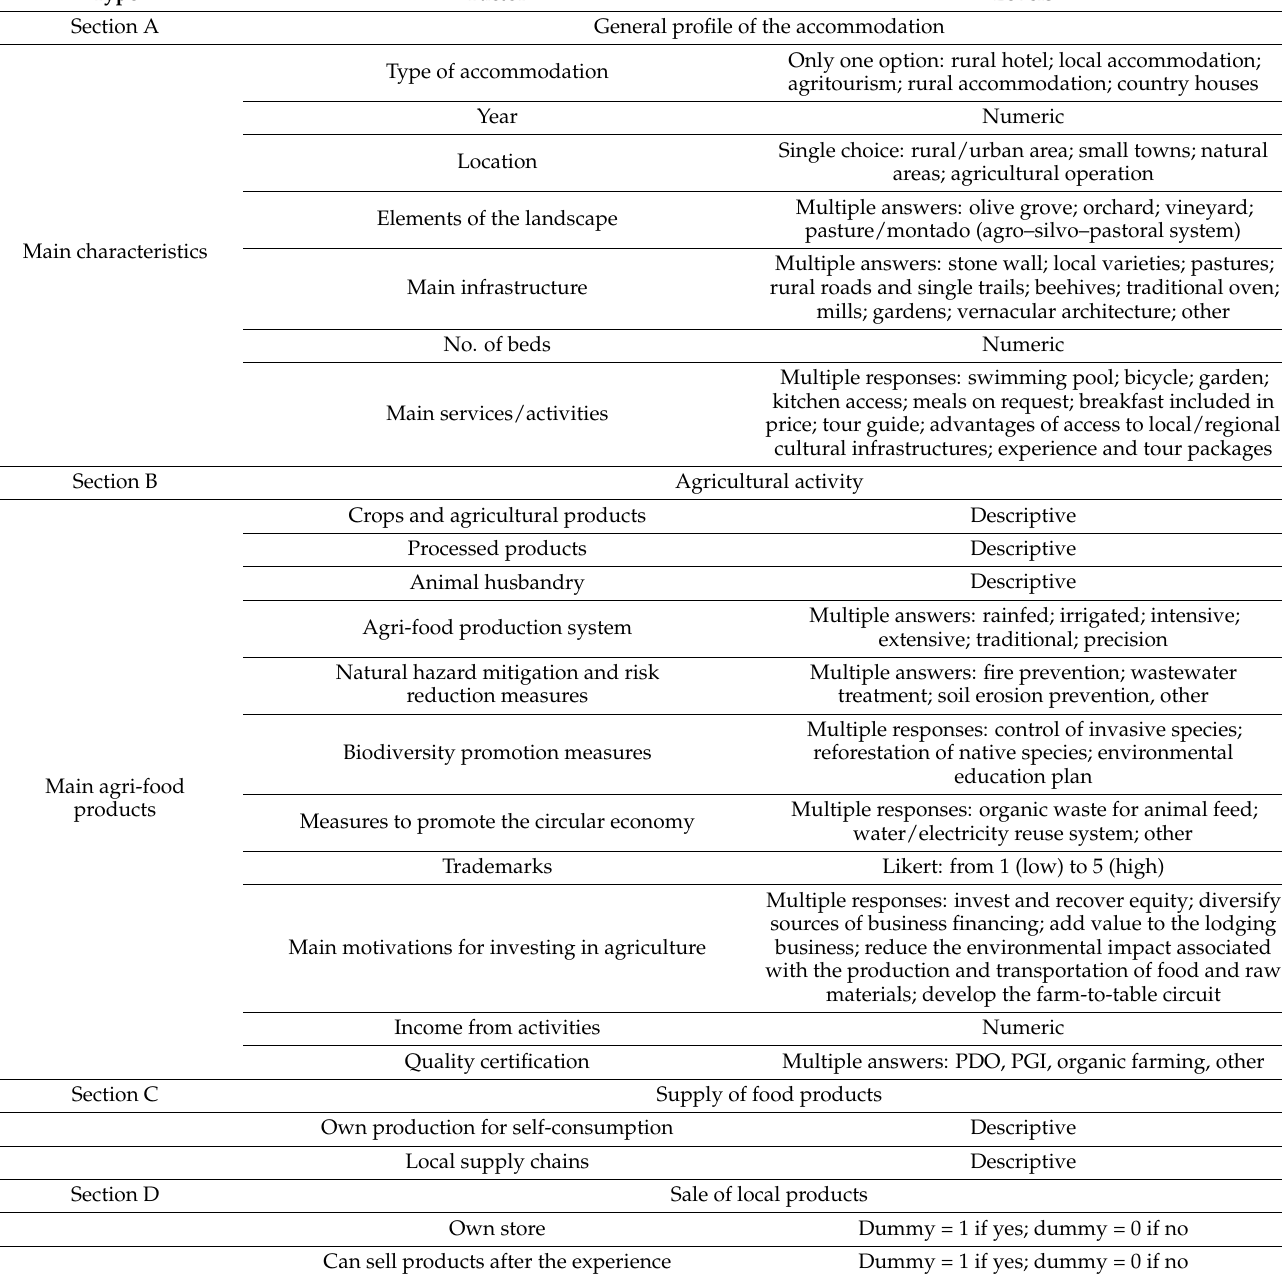
Table A1. Variables collected in the survey to describe the supply of rural lodgings and to identify relationships with the agricultural